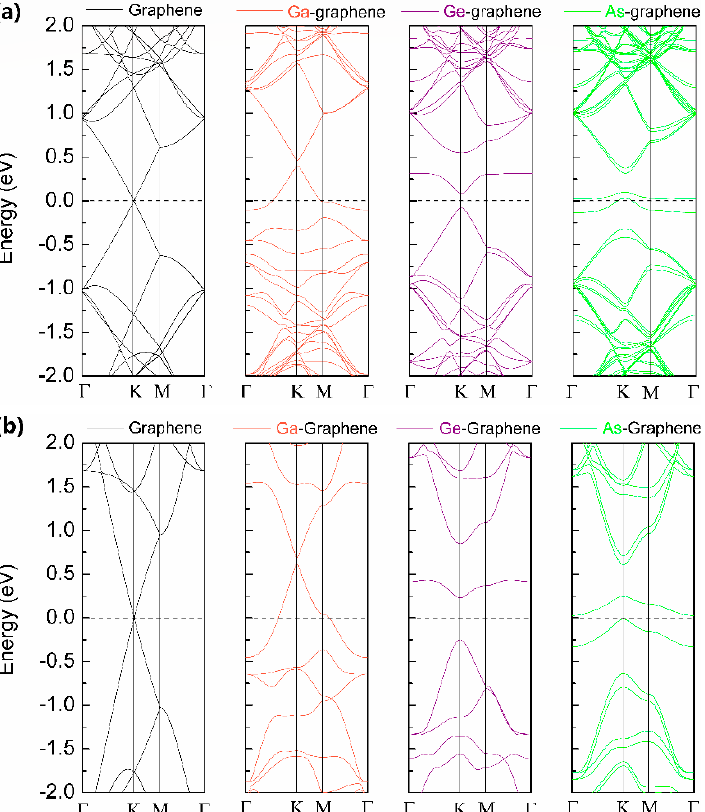
Figure 6. The band structures of pristine and heavy elements doped graphene. ( a , b ) are the band structures of hexagonal 4 × 4 and 8 × 8 supercells. The band gaps of a single Ga/Ge/As atom-doped 4 × 4 supercell are about 0.1 eV, 0.5 eV and 0.4 eV, respectively.